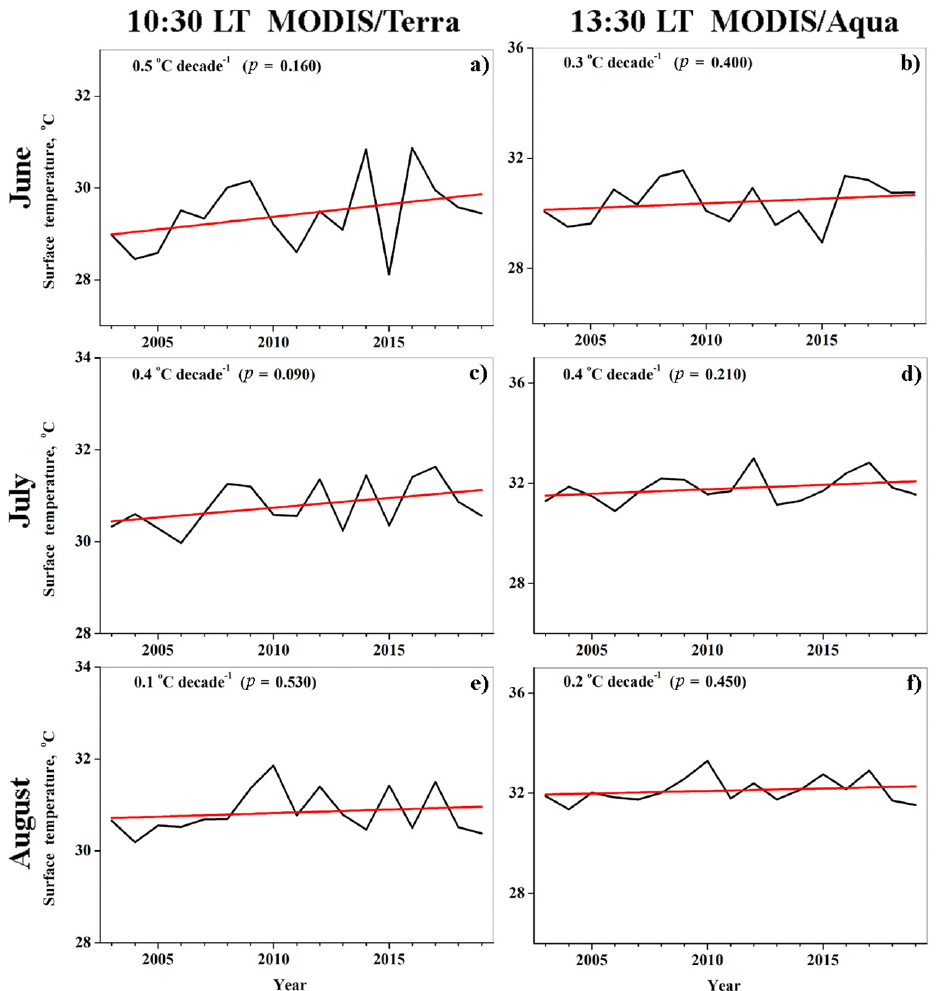
Figure 12. Satellite-based MODIS trends in daytime SWT (averaged over the whole Kinneret water area), in the summer months, based on ( left column ) ( a , c , e ) MODIS/Terra data at 10:30 LT and on ( right column ) ( b , d , f ) MODIS/Aqua data at 13:30 LT. The top panel ( a , b ) corresponds to June, the middle panel ( c , d ) corresponds to July, and the bottom panel ( e , f ) corresponds to August. The straight red lines designate linear fits.